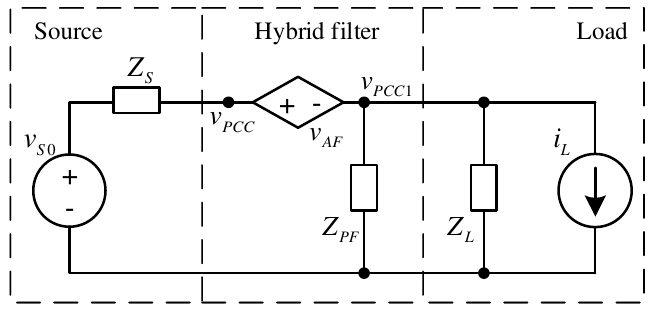
Figure 7. Combined system of the shunt passive filter and the series active